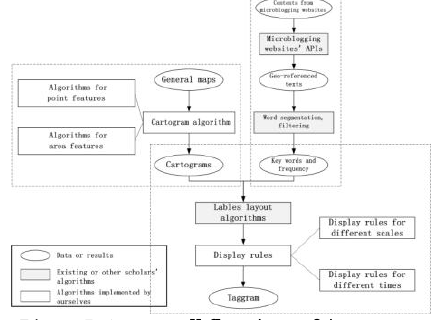
Figure 5. An overall flowchart of the